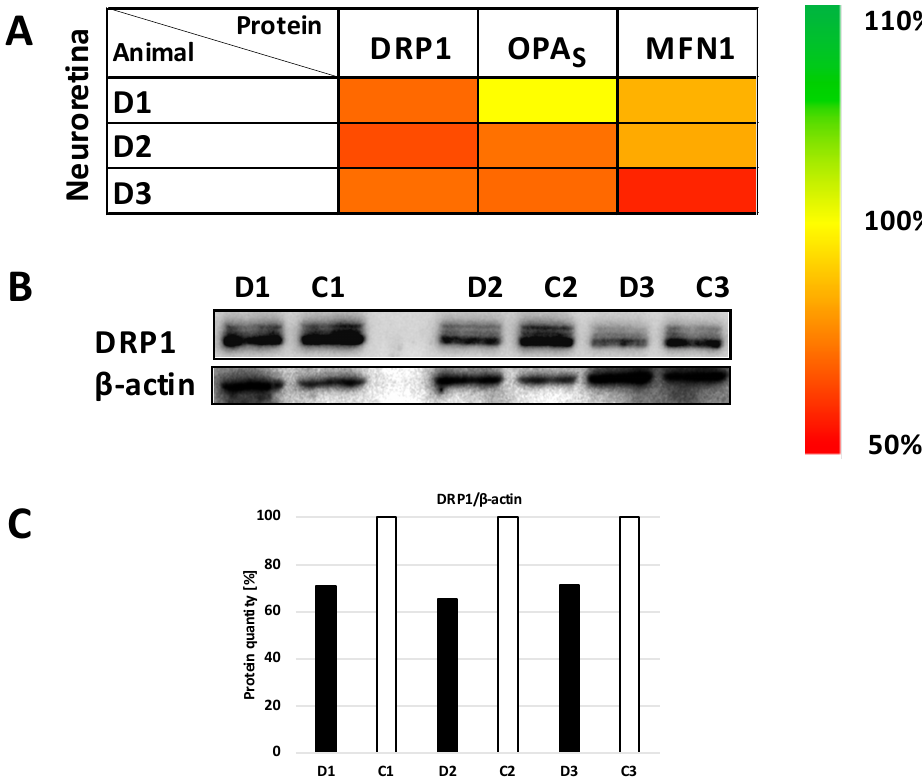
Figure 6. Changes in mitochondrial quality control proteins content in neuroretina layer of minipig eyes after high intraocular pressure-induced retinal ischemia. ( A ) The heatmap of Dynamin-related protein 1 (DRP1), short form of optic atrophy (S-OPA) and Mitofusin 1 (MNF1) expression. The results from SDS/WB evaluation were normalized to β -actin and compared to the control eye of each minipig. Scale on the right shows the degree of the expression change. D1, D2 and D3 are eyes after high intraocular pressure-induced retinal ischemia. ( B ) A decreasing trend of DRP1 protein content after normalization to β -actin was found in neuroretina after intraocular pressure elevation compared to control samples ( p < 0.01). Lysates from homogenates of diseased/retinal ischemia (D1, D2, D3) and control (C1, C2, C3) eyes were analyzed by SDS-PAGE. Briefly, 10 µ g of total protein was separated in 12% glycine gel and detected. Representative SDS/WB is shown. ( C ) Quantification of the Western blot signal (shown in panel ( B )). The intensity of the bands was quantified by Quantity One software and their values were normalized to β -actin. D1, D2 and D3 are right eyes of minipig 1–3 after high intraocular pressure-induced retinal ischemia; C1, C2 and C3 are left control eyes of each minipig. Further comparisons of groups (control eyes versus eyes after intraocular pressure-induced retinal ischemia) are shown in Supplementary Figure S4.